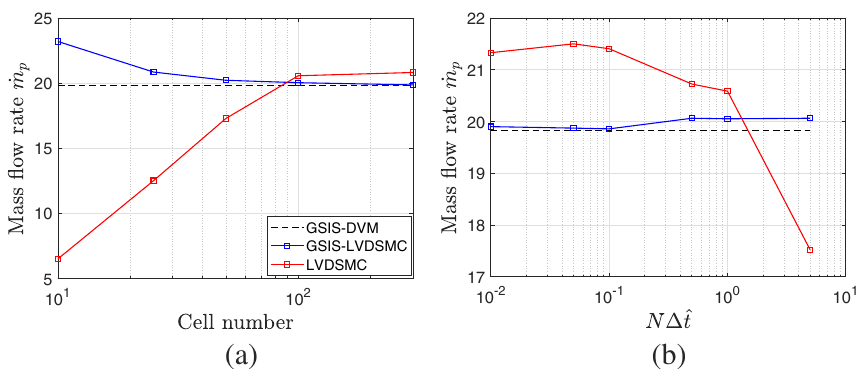
Fig. 8 The mass flow rate for 1D Poiseuille flow obtained by GSIS-LVDSMC (blue lines) and LVDSMC (red lines) changes with a the cell number and b the time step when Kn = 0.01 . The black dotted line is obtained by GSIS-DVM with reasonable cell width and time steps, which are given in Ref.